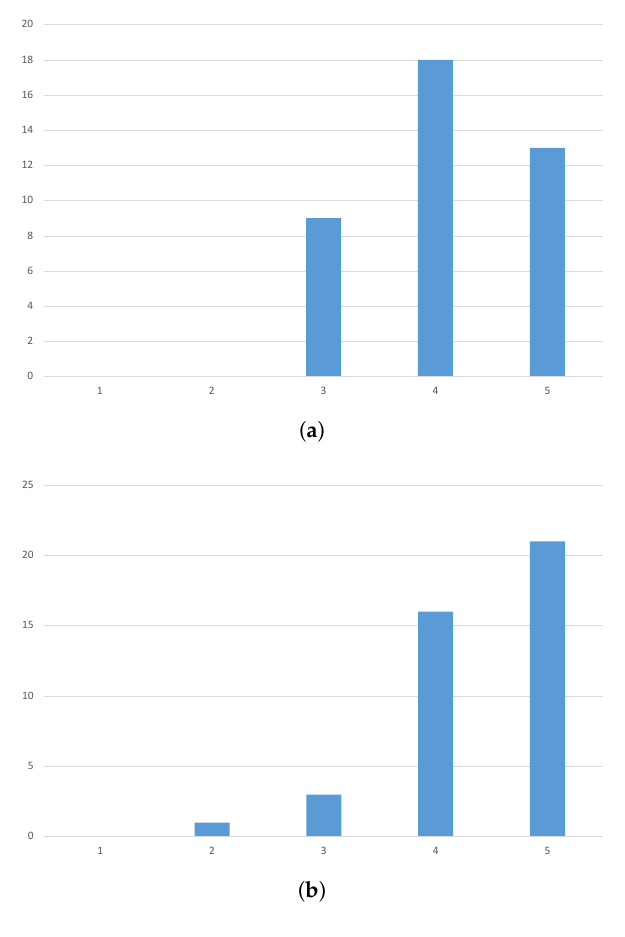
Figure 8. The results of the user experience evaluation of the proposed system. ( a ) “Express how much did you enjoy using the tool”; ( b ) “Describe how effective it